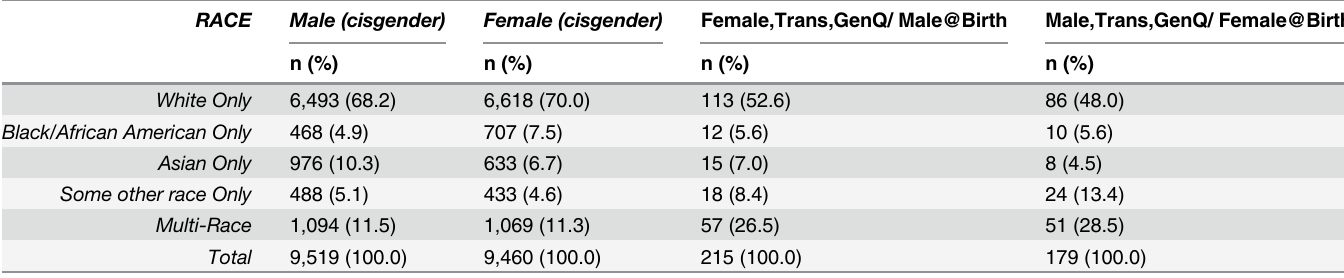
Table 9. Race and Transgender Status in a Google Android Panel